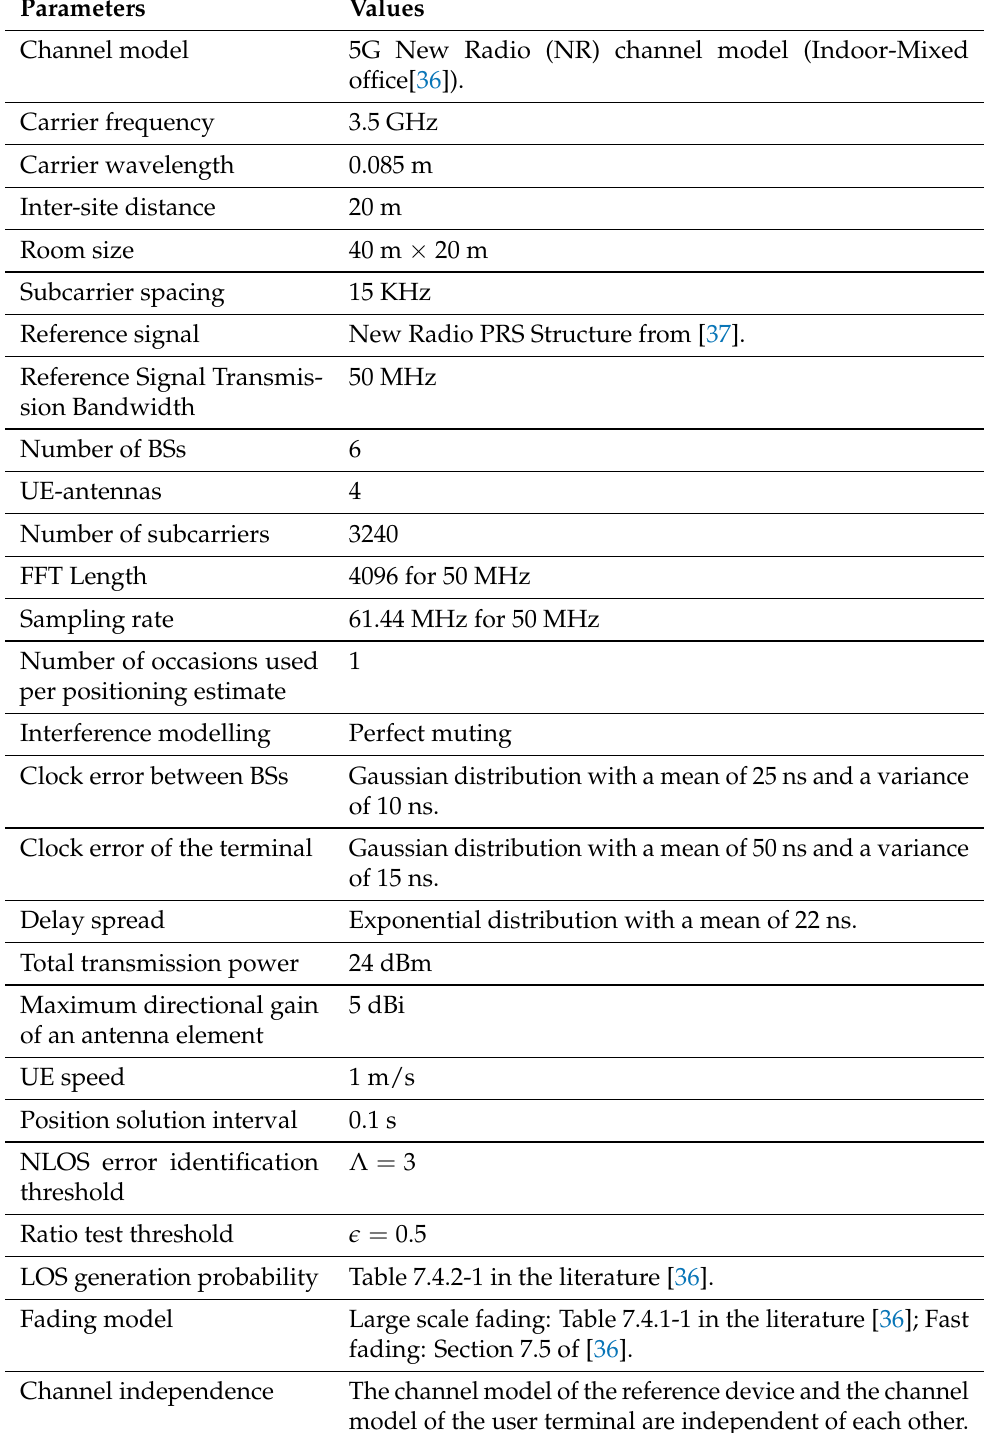
Table 1. System Parameters.